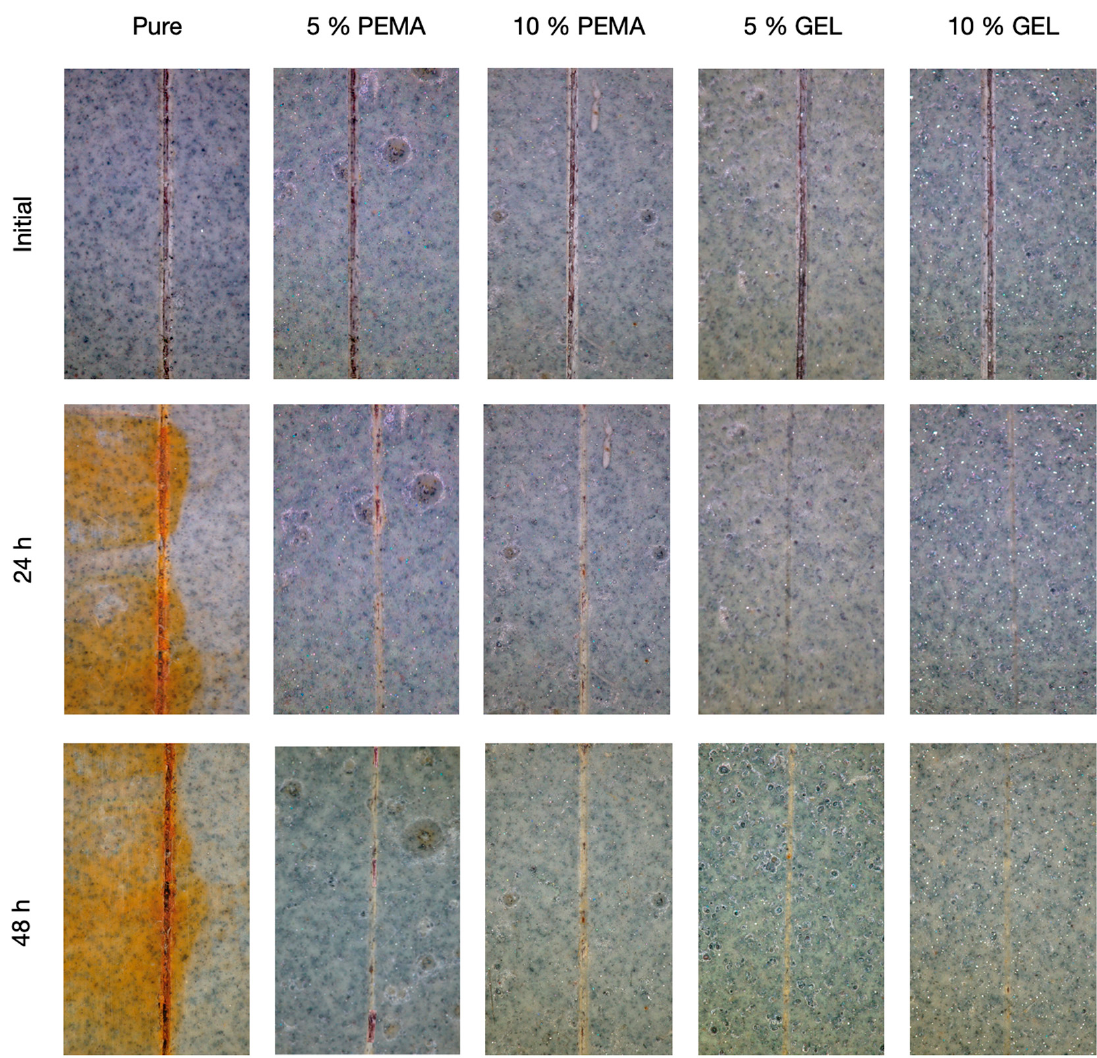
Figure 15. Steel substrates coated with the epoxy primer with and without the addition of 5 wt. % and 10 wt. % PEMA and GEL samples, immersed in 3.5 wt. % NaCl solution for 24 h and 48 h.